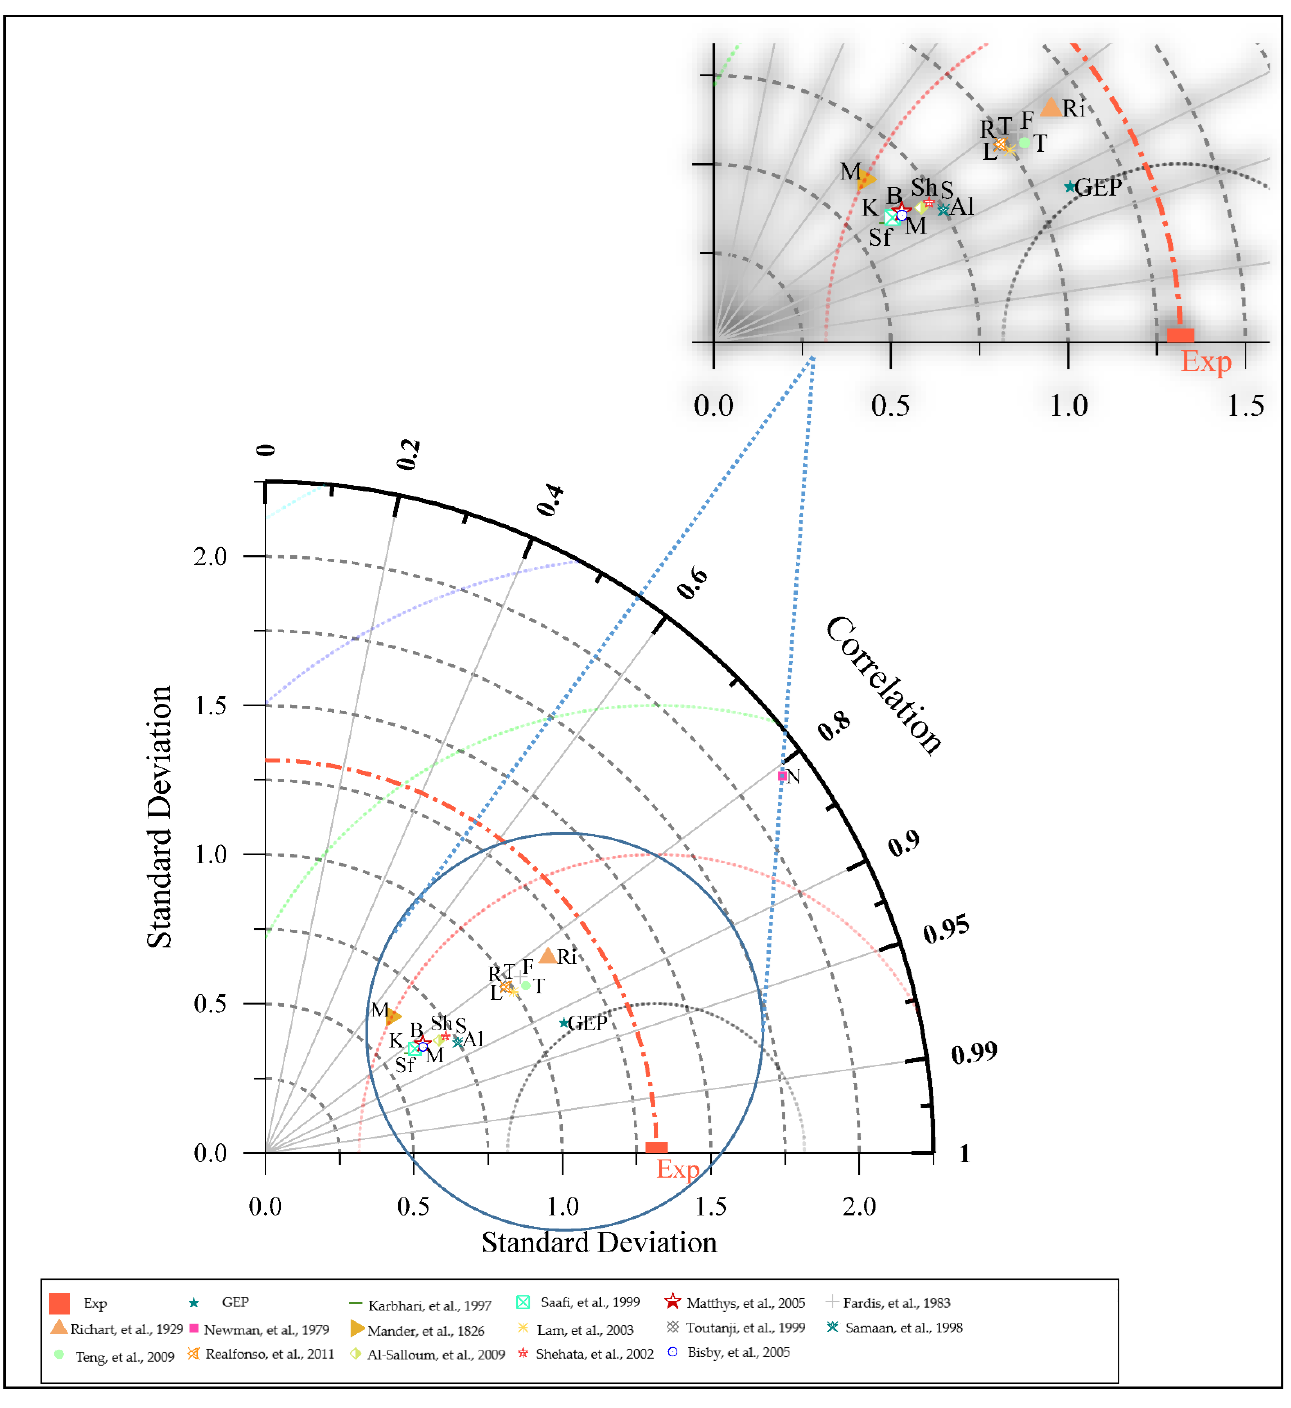
Figure 5. Taylor Diagram for performance evaluation of GEP and existing models [11,12,14 – 16,20,22,79 – 86].